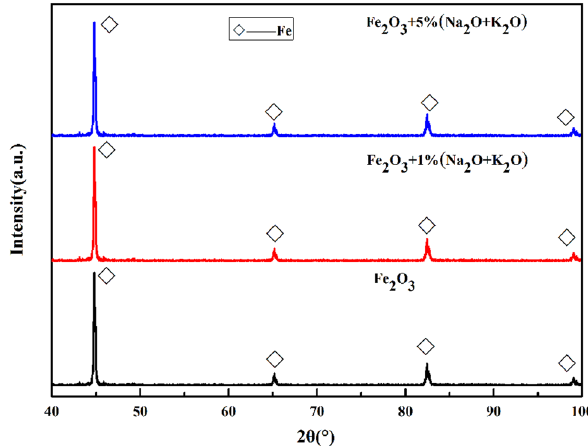
Figure 15: XRD analysis of reduced briquettes with vary ( K + Na ) at the third 2 O 2 O